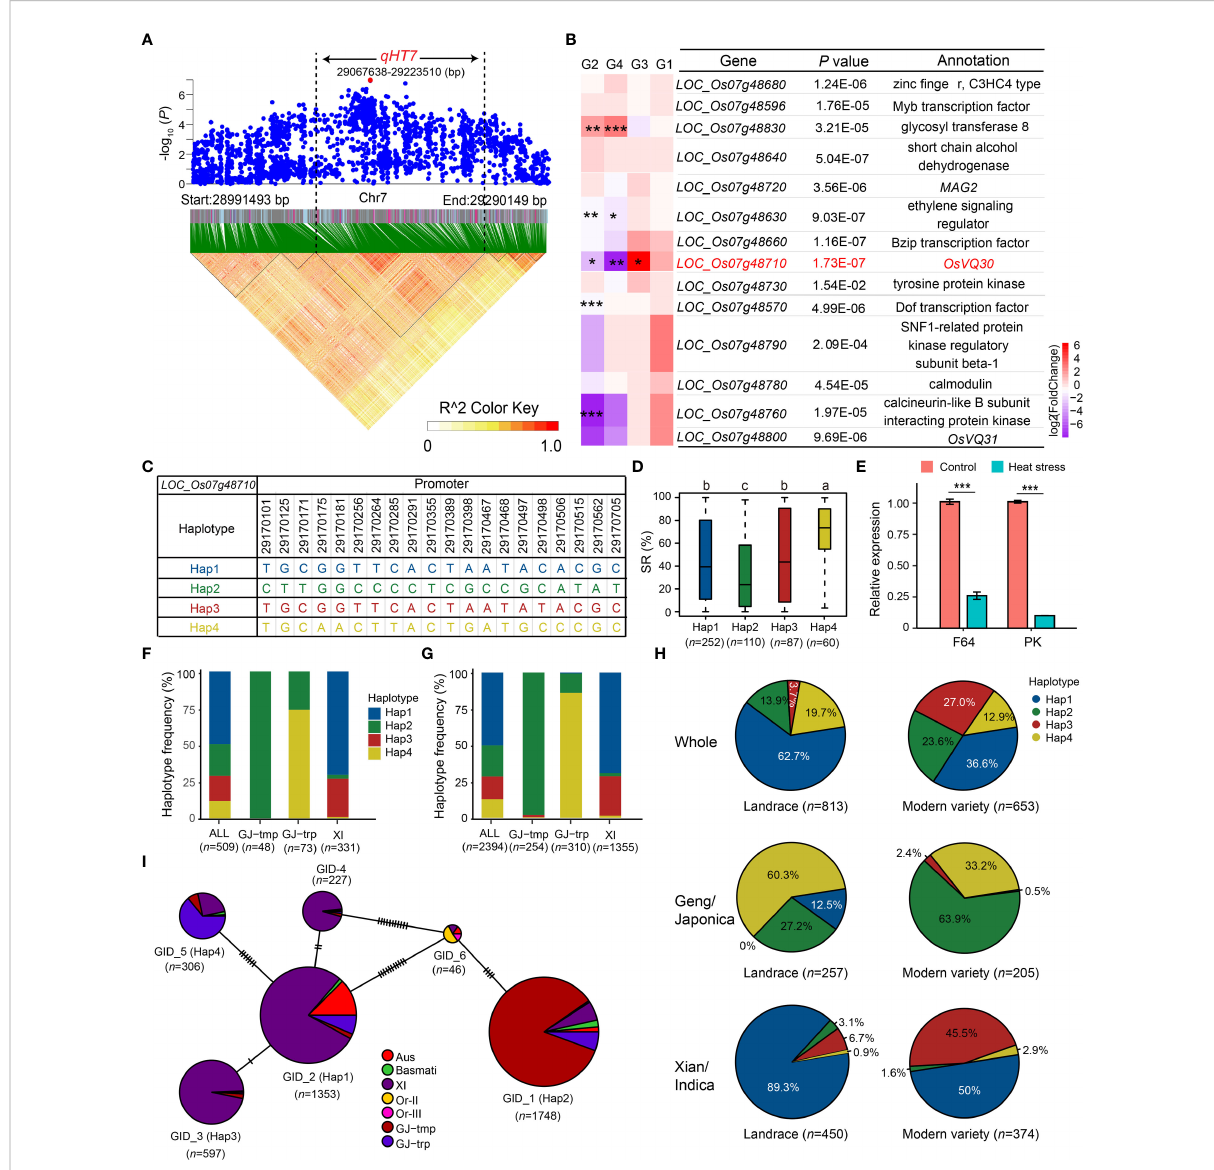
FIGURE 4 Candidate gene analysis of qHT7 . (A) Local Manhattan plot (top) and LD analysis (bottom) of 150-kb upstream and downstream around the lead SNP rs7_29140282. The red dot is the lead SNP, and its LD block region is marked by the black dotted lines. (B) Relative expression of 14 annotated genes in qHT7 . *** FDR < 0.001, ** FDR < 0.01, * FDR < 0.05. G1: F64_Control vs PK_Control; G2: F64_HS vs F64_Control; G3: F64_HS vs PK_HS; G4: PK_HS vs PK_Control. (C) Haplotype of LOC_Os07g48710 , which is the promising candidate gene of qHT7 . (D)